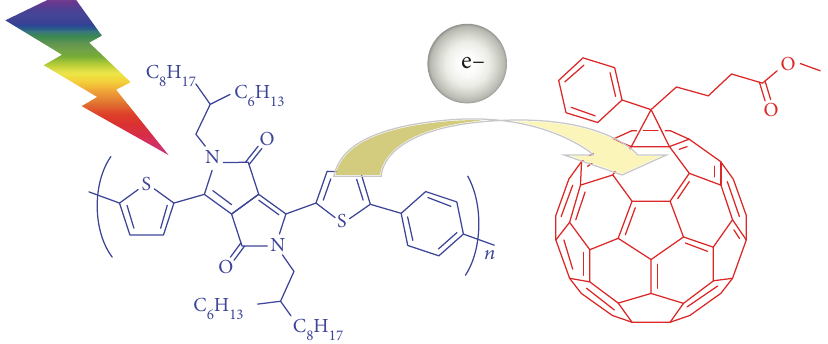
Figure 1: Molecular structures of the components used in this study, the PDPP polymer and [60]PCBM.